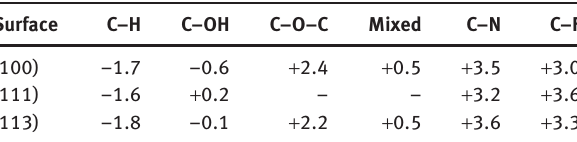
Mixed means smooth diamond surface with the combination